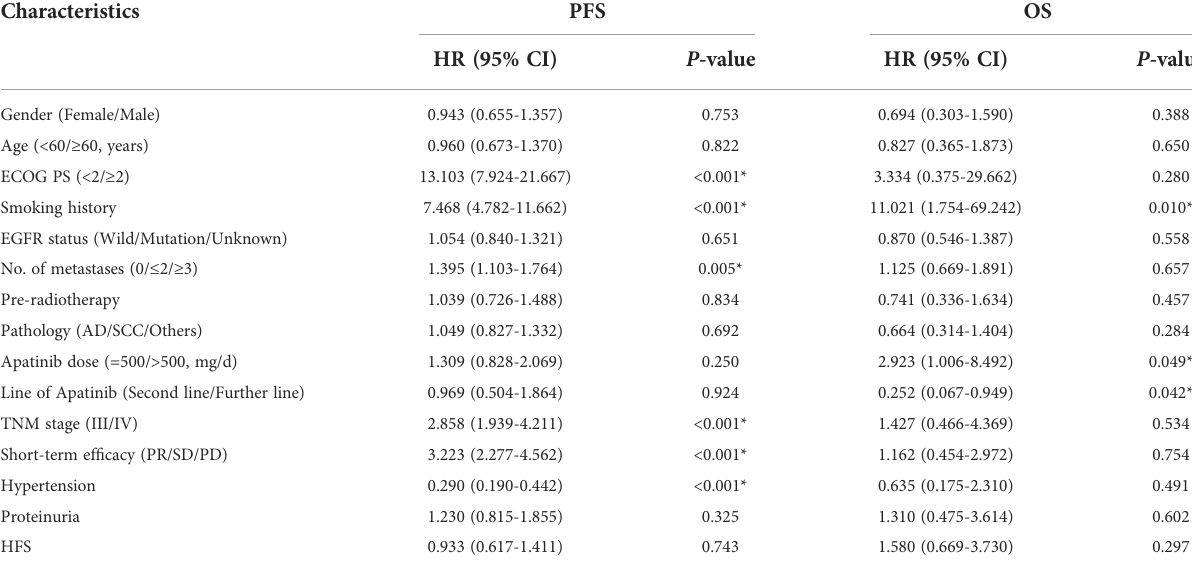
TABLE 2 Univariate analysis of PFS and OS.